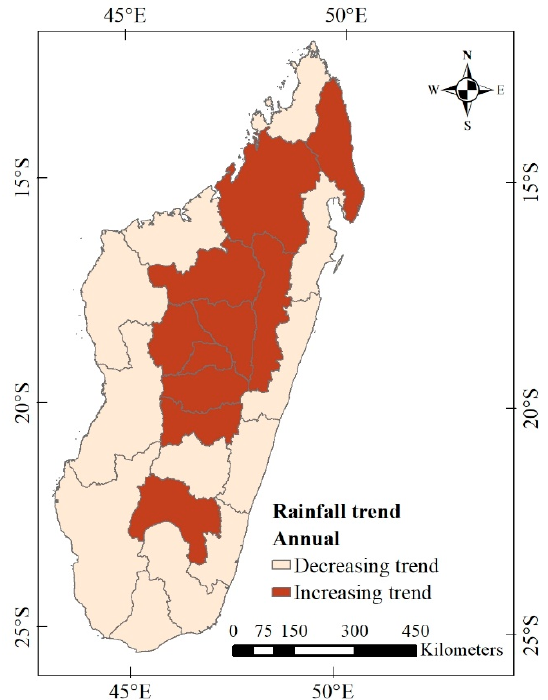
Figure 5. Results of the M-K test for annual rainfall in each region of Madagascar.